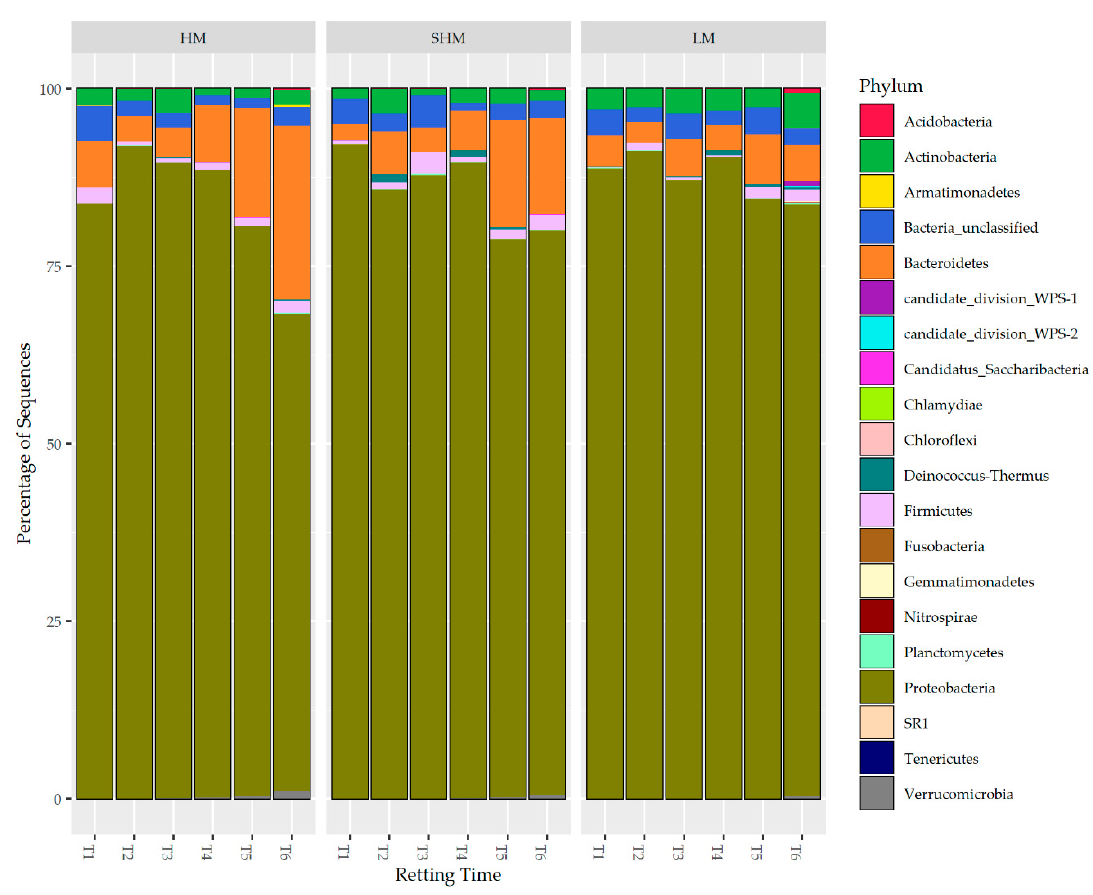
Figure 2 . Relative abundance of Phyla according to treatment over time. Figure 2. Relative abundance of Phyla according to treatment over